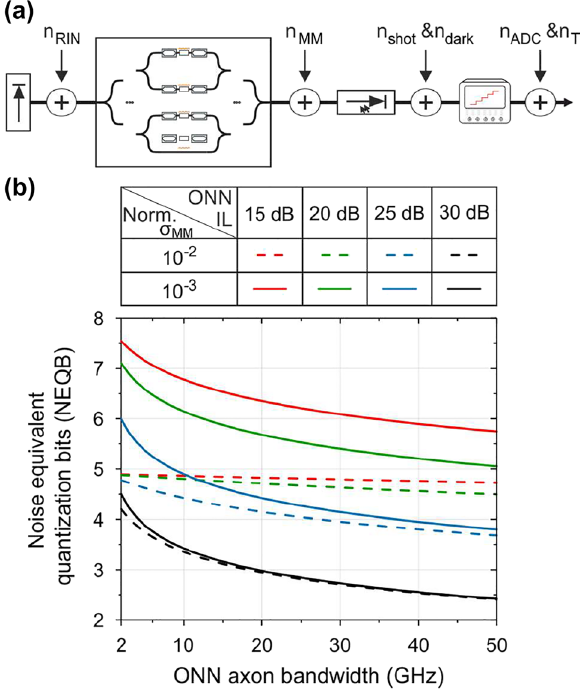
Figure 2: PNN noise analysis: (a) Electro-optic ONN link noise sources breakdown. (b) Noise equivalent quantization bits versus the bandwidth per ONN’s axon for different values of ONN power budget and matrix multiply noise standard deviation